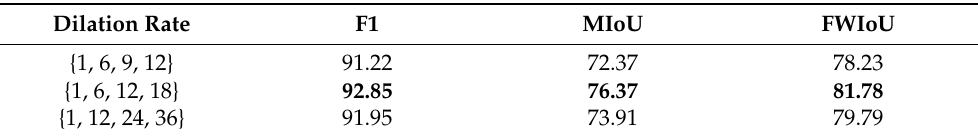
Table 3. Comparison of F1, MIoU, and FWIoU with the different dilation rates (%) on the 2020 Gaofen challenge water body segmentation